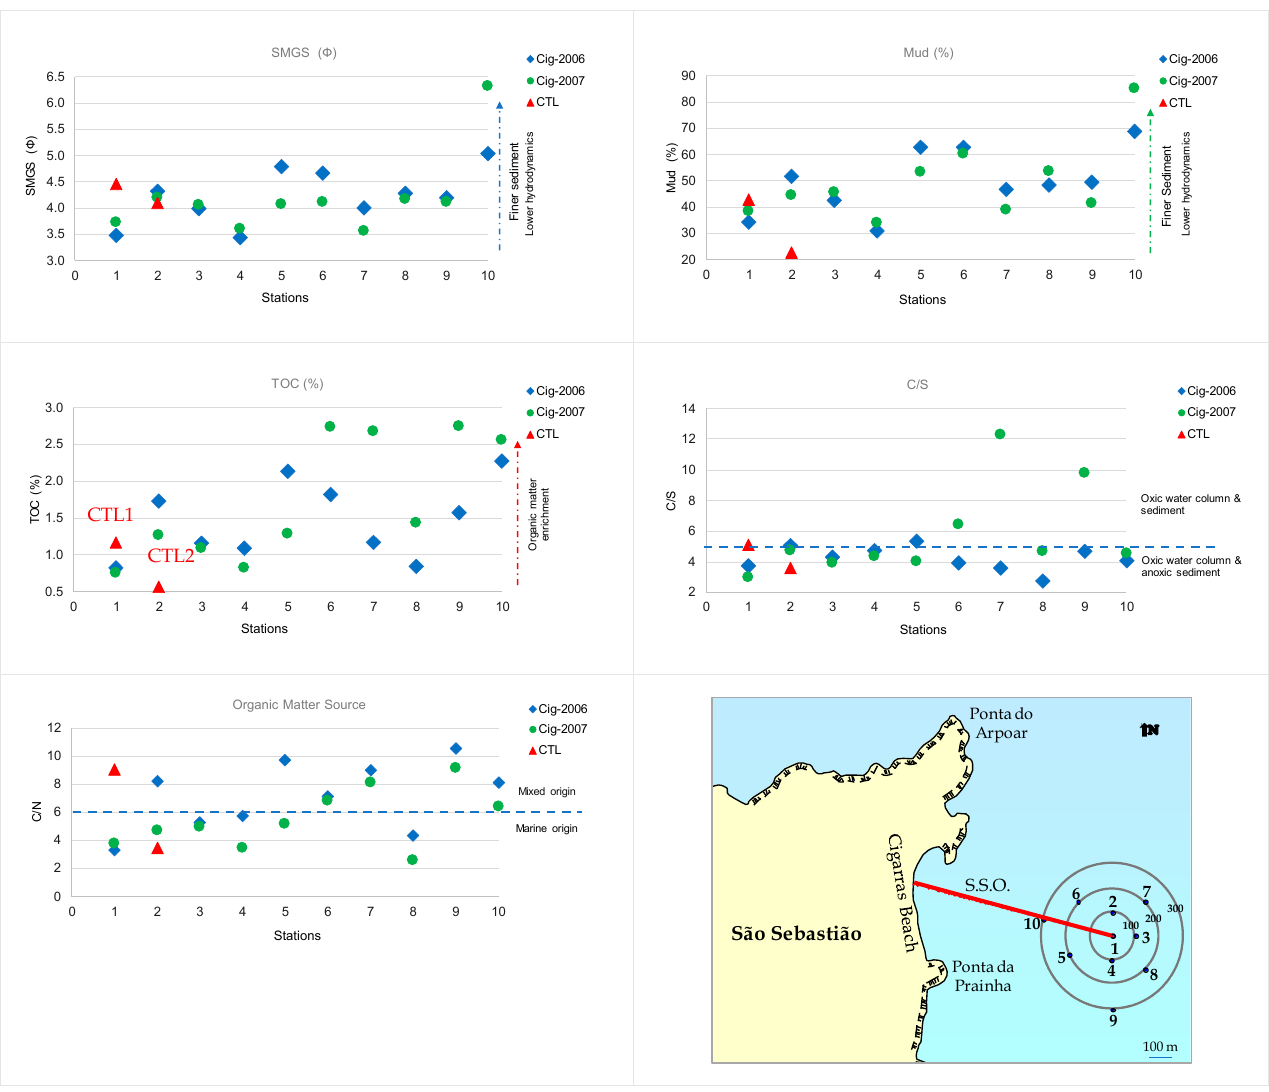
Figure 3. Comparison of sediment mean grain size (SMGS), mud (fine) sediment content and TOC, S, N, C/S, and C/N values in 2006 (blue) and 2007 (green) in the analyzed stations near the Cigarras submarine outfall and in 2008 (red, see TOC figure for details) in the control stations from São Sebastião Channel.